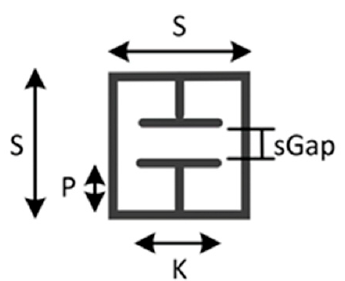
Figure 5. ELC resonator used in this work.